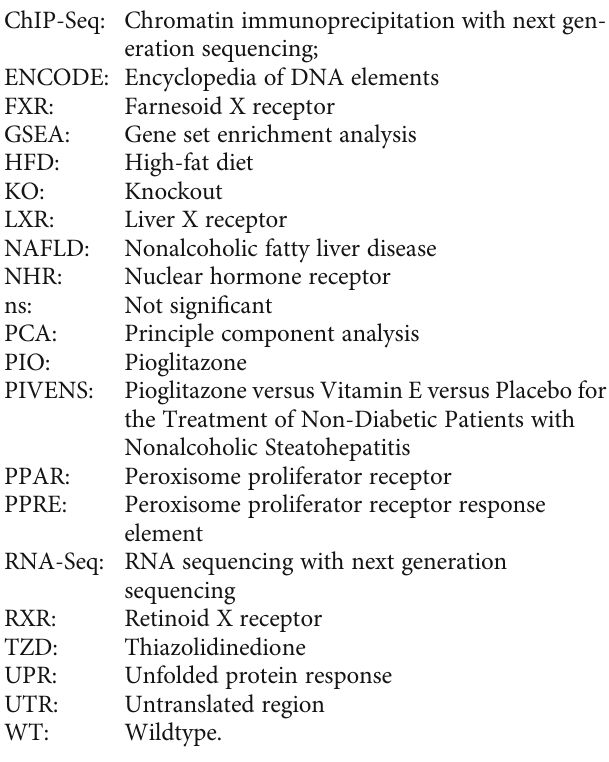
Supplementary Figure S1: immunoblot analysis of the anti-